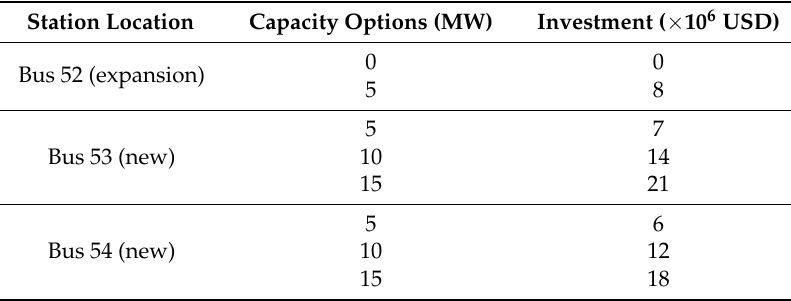
Table 1. Substation expansion or new construction options.